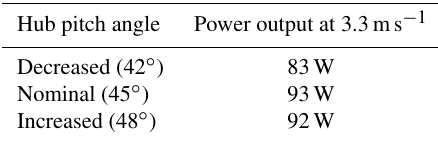
Table 1. Impact of hub pitch angle on ducted configuration. Hub pitch